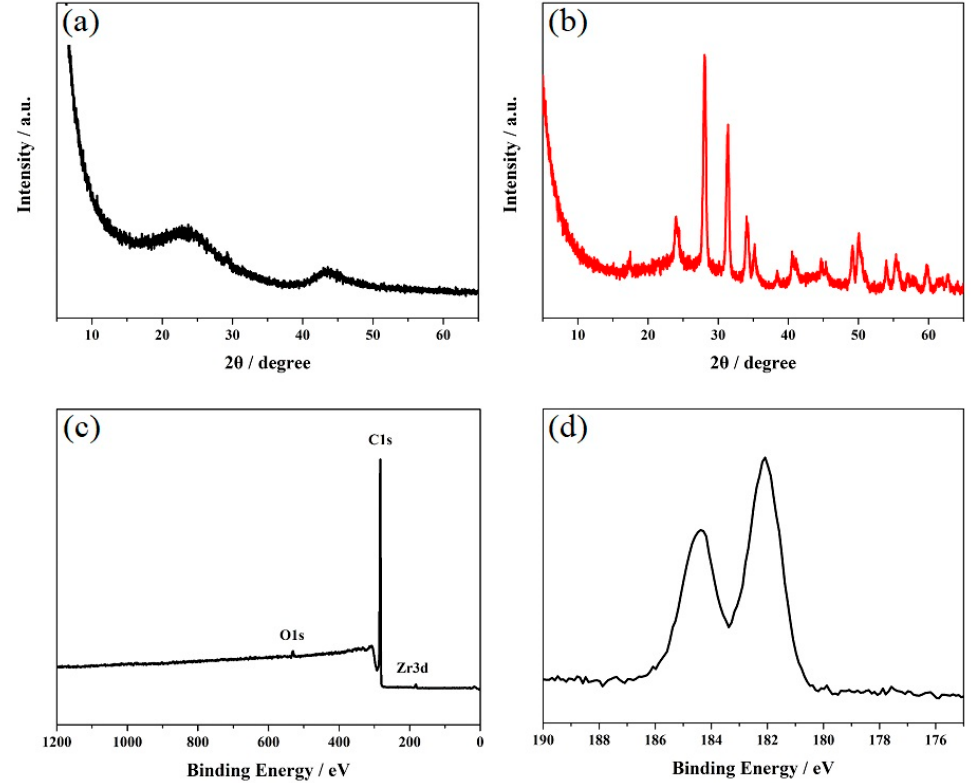
Figure 1. X-ray diffraction (XRD) patterns of ( a ) carbon black (VXC-72R) and ( b ) VXC-72R/ZrO 2 nanocomposites. X-ray photoelectron spectroscopy (XPS) spectra of ( c ) VXC-72R/ZrO 2 nanocomposites and the ( d ) Zr element.